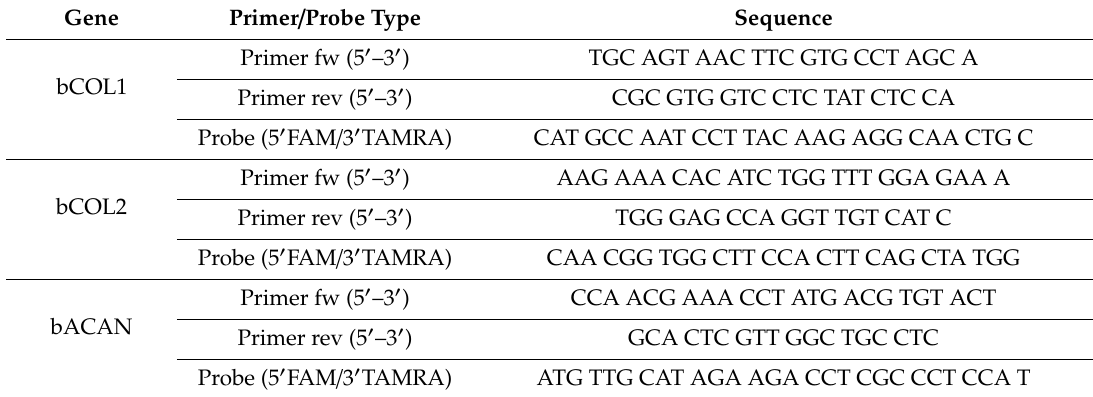
(Table 1) using TaqMan Universal Master Mix (Applied Biosystems, cat. # 4324018, Carlsbad, CA). QuantStudio6 Flex Instrument and software (Applied Biosystems) were used for qPCR. Ribosomal protein lateral stalk subunit P0 (RPLP0) was used as the endogenous control. The comparative Ct method was performed for the relative quantification of target mRNA. Table 1. Oligonucleotide primers and probes (bovine and human) used for qRT-PCR. Primers and probes with the sequence shown were custom-designed; primers and probes with the catalog number were from Applied Biosystems. fw: Forward, rev: Reverse, FAM: Carboxyfluorescein, TAMRA: